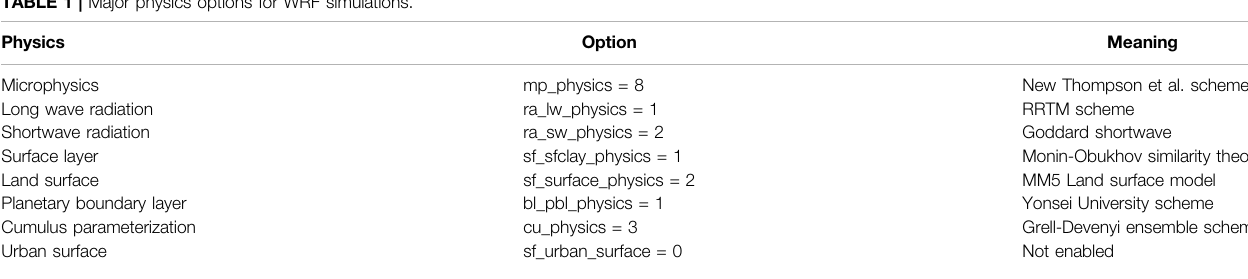
TABLE 1 | Major physics options for WRF